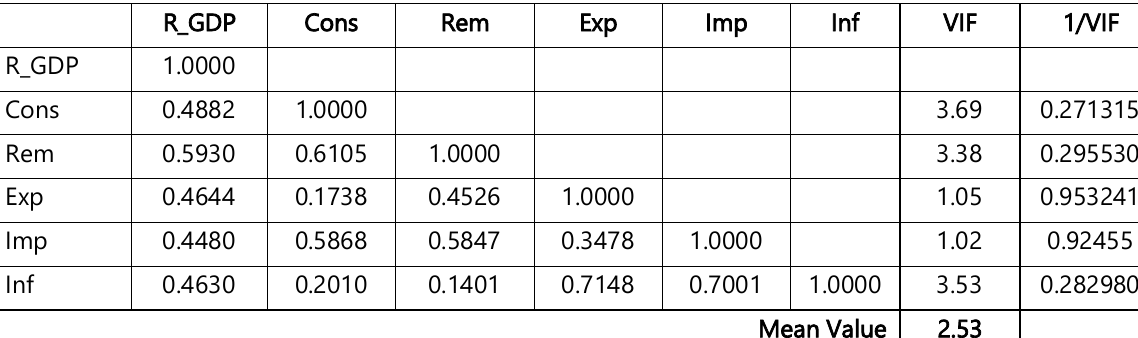
Table 3: Correlation Analysis and VIF (Source: Authors‘ calculation)